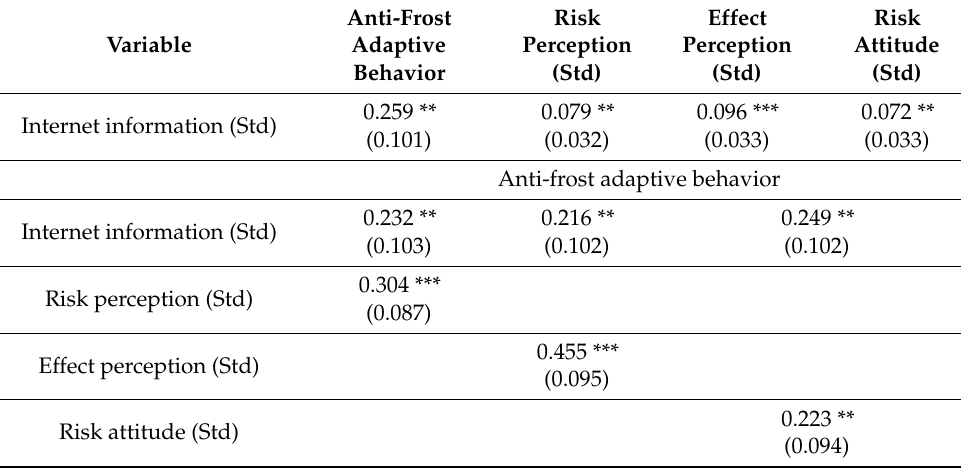
Table 7. The mediating effect of risk perception, effect perception and risk